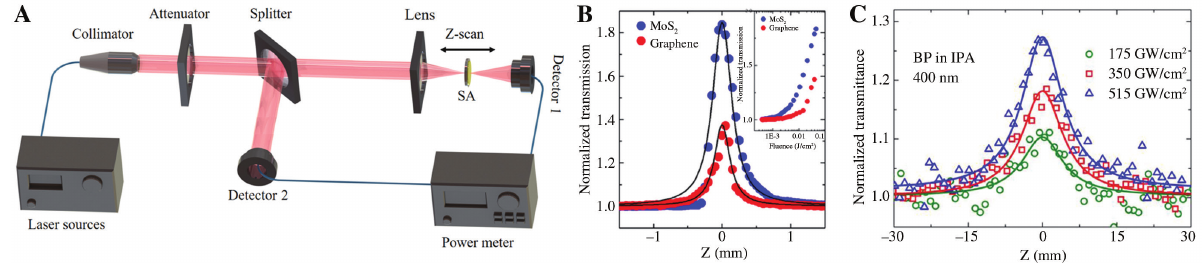
(T = 34.4%) and graphene (T = 16.5%) dispersions, 2